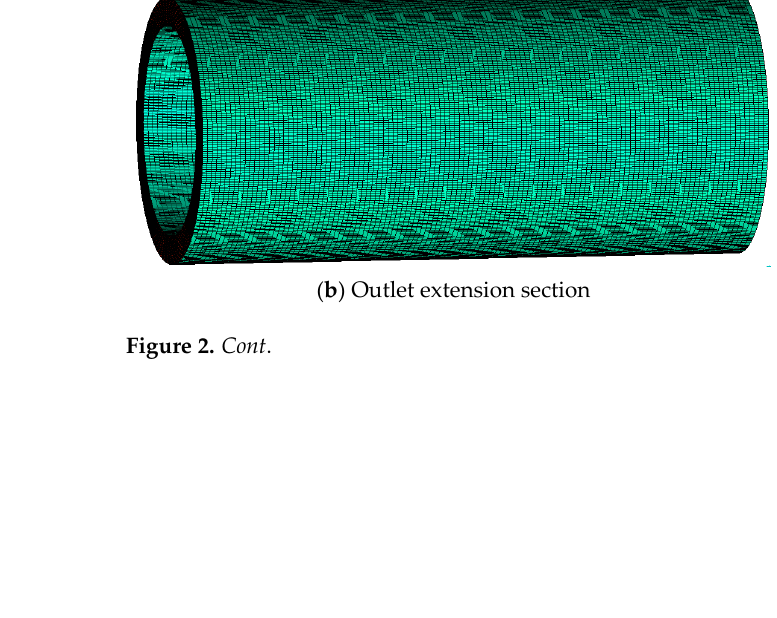
Table 1. Main design parameters of the multiphase pump.